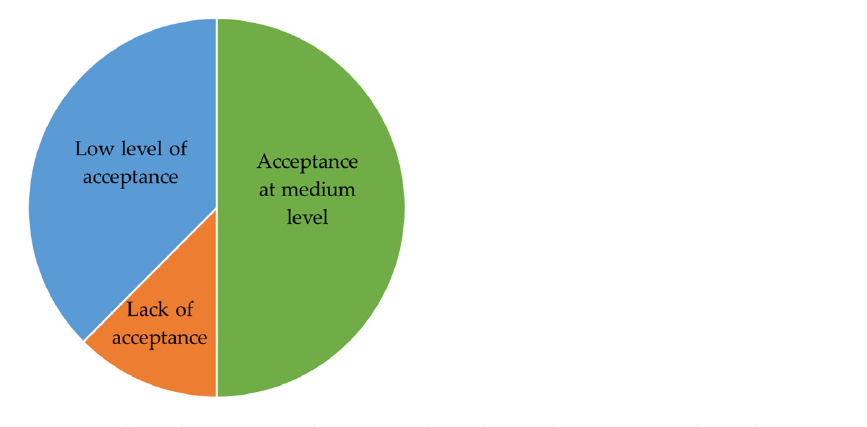
Figure 7. Selected survey results—an analytical–social perspective: how do you assess the level of acceptance by the residents of your province for the creation of RES installations (other than prosumer installations) near their place of residence?